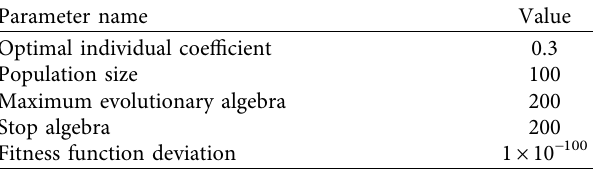
Table 12: Parameter table of NSGA-II